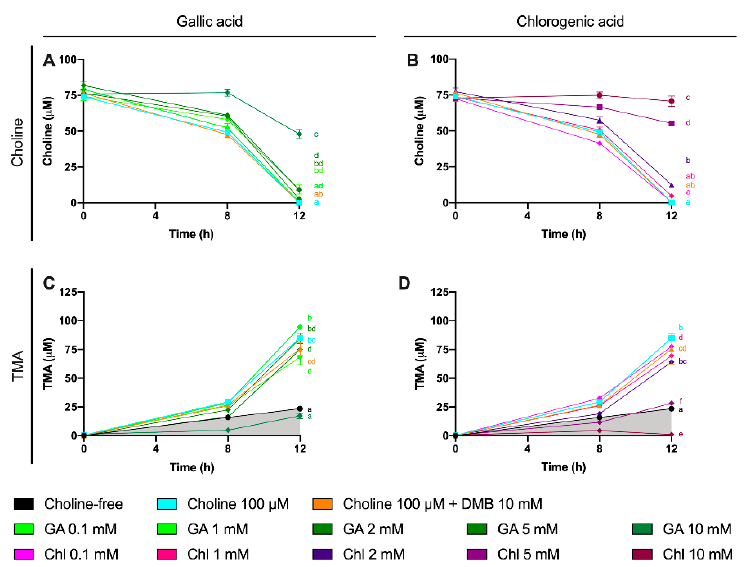
Figure 7. Choline ( A , B ) and TMA ( C , D ) kinetic curves obtained from optimal fermentations conditions (fecal slurry 20% and choline 100 µ M) supplemented with gallic acid or chlorogenic acid (0.1–10 mM). Results are expressed as mean (µM choline or TMA) ± SEM ( n = 6), and for choline, time-matched choline concentrations in the background (0 µM choline) are subtracted from choline-supplemented conditions. Different letters indicate statistical differences ( p < 0.05) by two-way (main effect of gallic acid or chlorogenic acid dose) ANOVA (Tukey’s post hoc test). Factors for two-way ANOVA were gallic acid or chlorogenic acid concentration and time. Grey shading indicates background TMA production. Abbreviations: TMA, trimethylamine; GA, gallic acid; and Chl, chlorogenic acid.